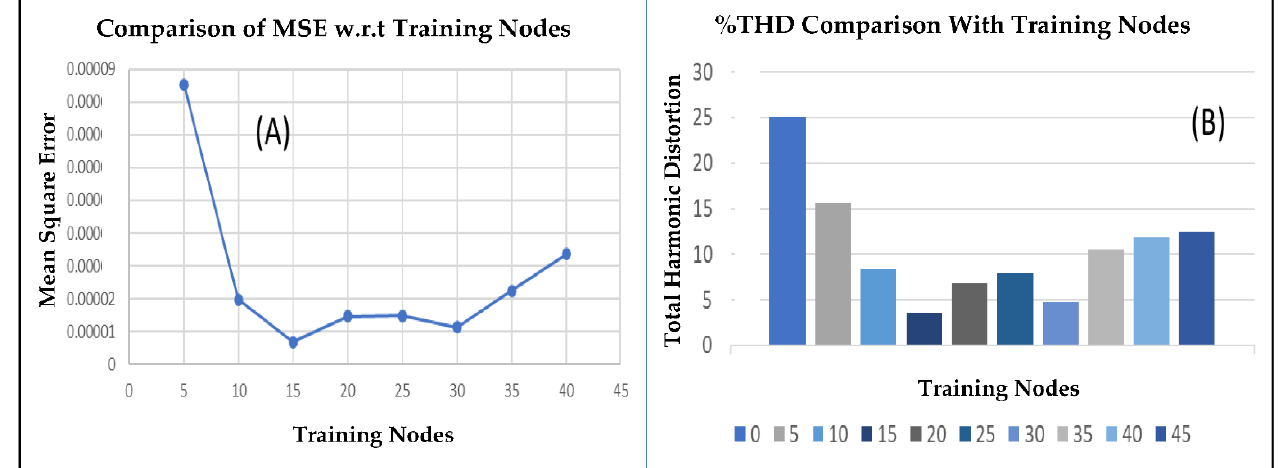
Figure 19. ( A ) MSE Versus Training Nodes. ( B )% THD Versus training nodes.